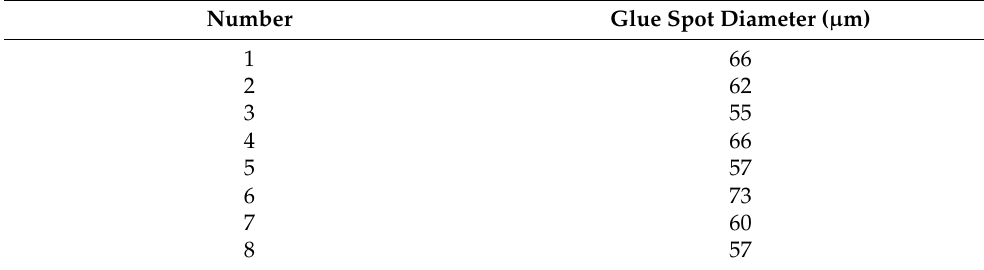
Table 3. Dispensing results of 10- µ m needle.